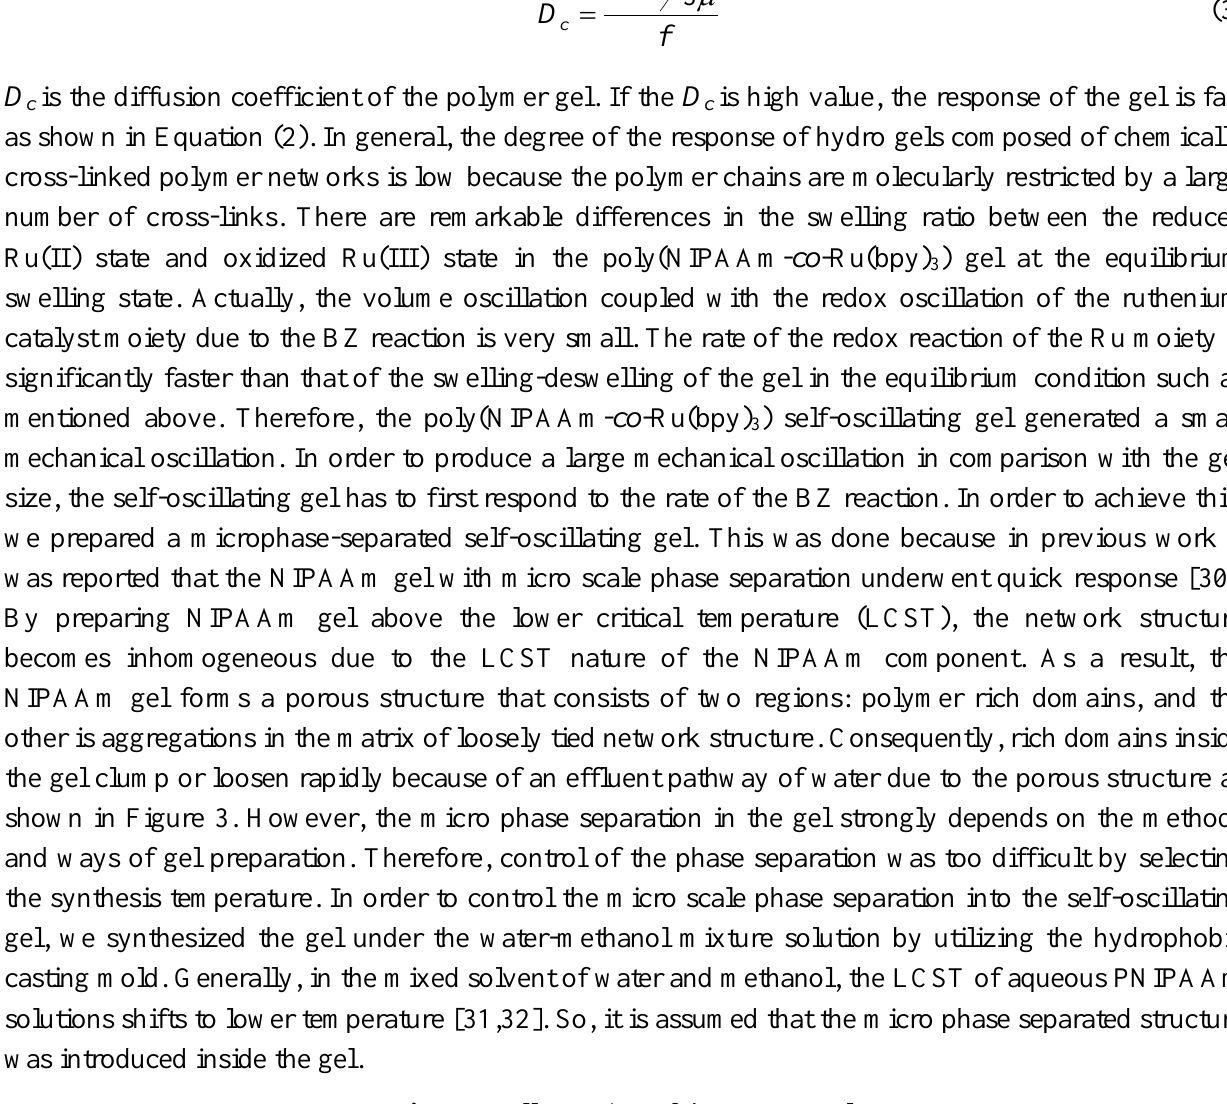
Figure 3. Illustration of the porous